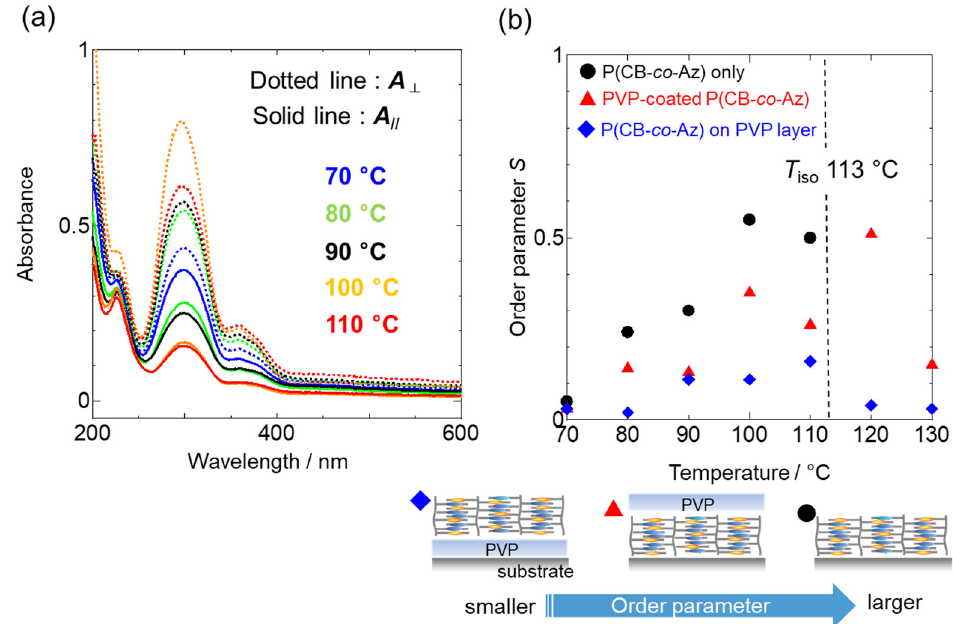
Figure 8. ( a ) Polarized UV-visible absorption spectra of P(Az-CB) film (thickness: 100 nm) without topcoat after LPL irradiation at various temperatures. Dotted and solid lines correspond to spectra taken perpendicular and parallel with irradiated LPL. ( b ) In-plane order parameter of P(Az-CB) films. Black, red and blue symbols correspond to data for pure P(Az-CB) film, P(Az-CB) film coated with PVP layer, and P(Az-CB) film formed on PVP underlayer, respectively. A scheme below b indicates the relationship between the film constitution and resulting in-plane S .